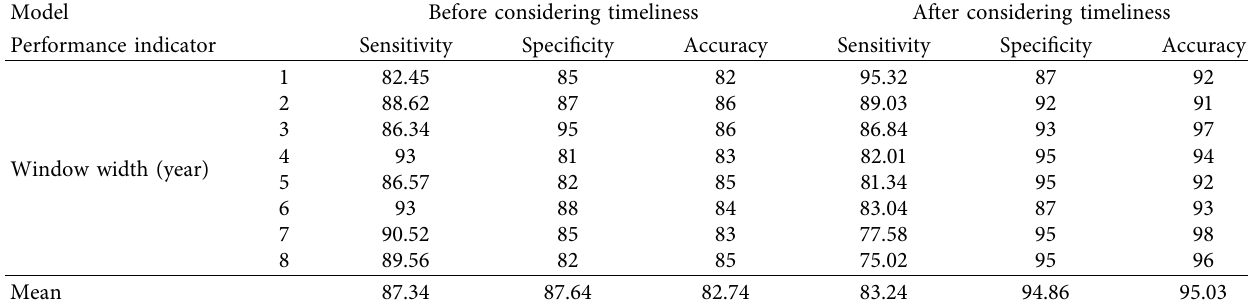
Table 4: Model prediction results before and after considering